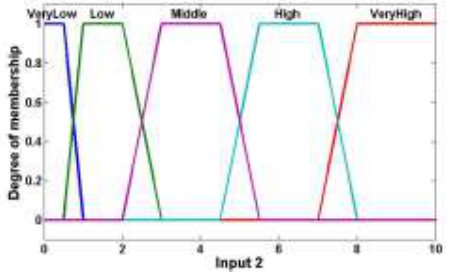
Figure 3. Membership functions of the Input 2